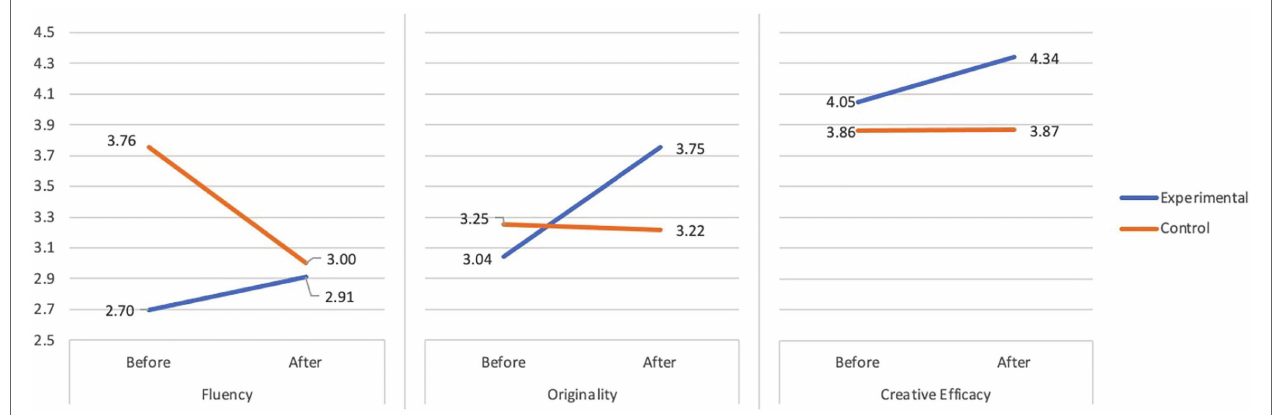
FIGURE 1 | The improvement of individual creativity in the experimental group and the control group.